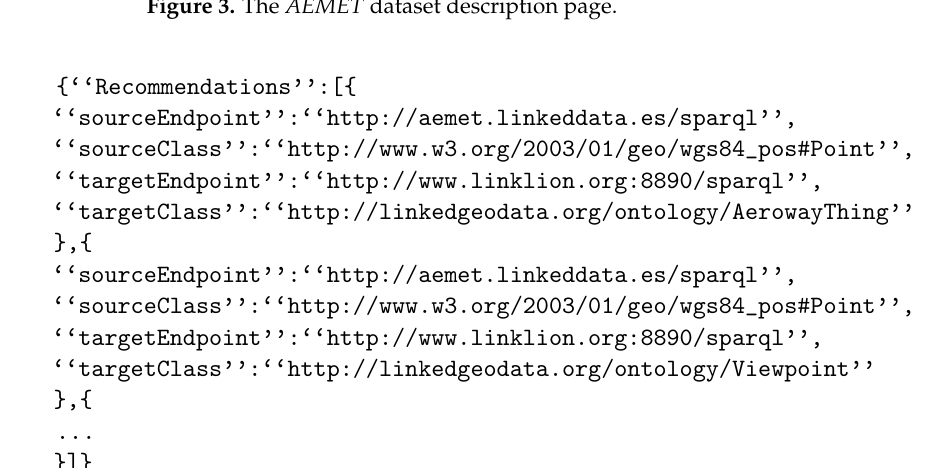
Figure 3. The AEMET dataset description